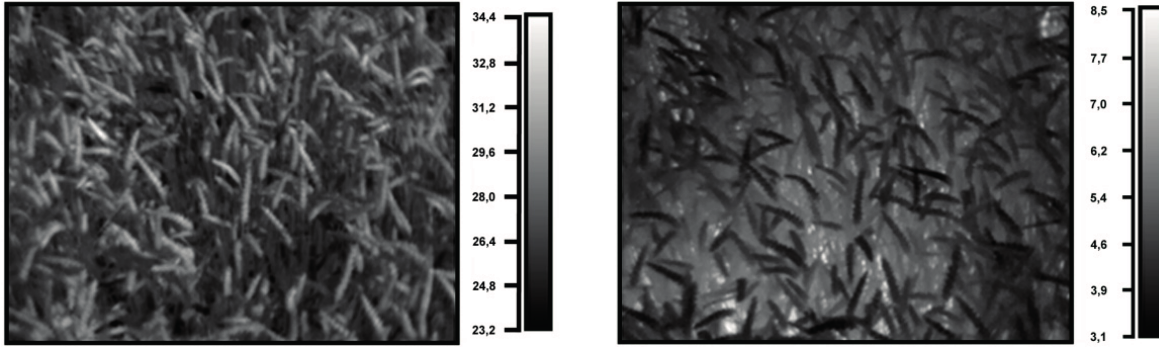
Figure 1. Sample thermal daytime ( left ; 07.23.2012; 15:55 UTC; air temperature: 25.8 °C; net radiation: 264.4 W·m − 2 ; wind speed: 2.3 m·s − 1 ; relative humidity: 30.5%, temperature range: 23.4 °C (black) to 34.5°C (white)) and nighttime ( right ; 07.22.2012; 1:54 UTC; air temperature: 7.4 °C; net radiation: − 48.9 W·m − 2 ; wind speed: 0.3 m·s − 1 ; relative humidity: 94.6%, temperature range: 2.9 °C (black) to 8.5 °C (white)) images of the wheat canopy (observed area: ~1 m × 1